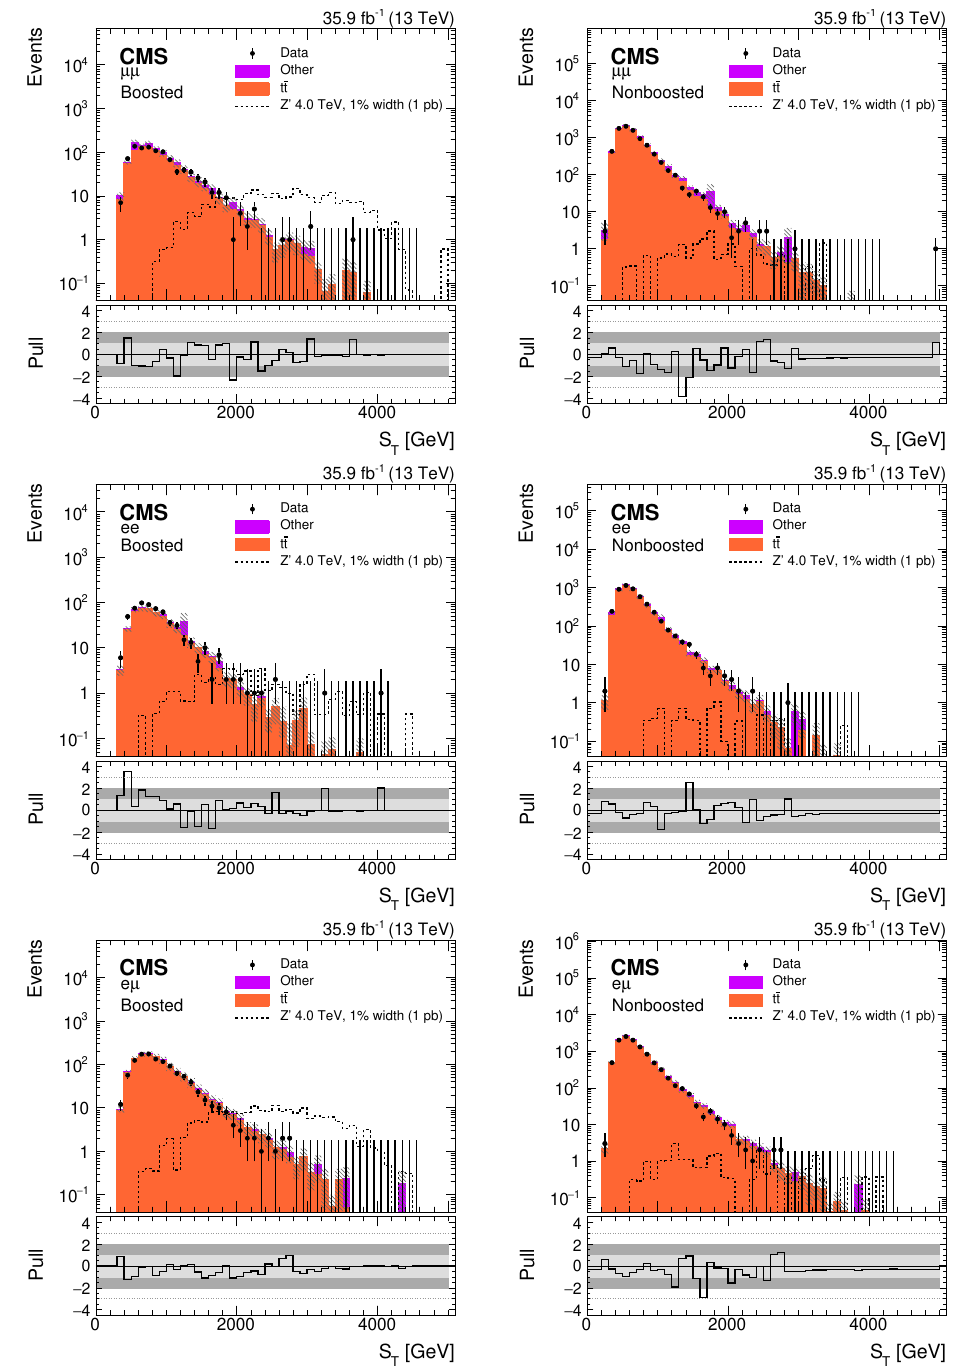
Figure 8 . Distributions of S T for the (cid:22)(cid:22) (upper), ee (middle), and e (cid:22) (lower) SRs in the boosted (left) and nonboosted (right) regions, as de(cid:12)ned in section 6.1. The contribution expected from a 4 TeV Z 0 boson, with a relative width of 1%, is shown normalized to a cross section of 1 pb. The hatched band on the simulation represents the uncertainty in the background prediction. The lower panel in each plot shows the pull of each histogram bin from the SM prediction. The light (dark) gray band represents a pull of one (two) s.d. from the predicted value.